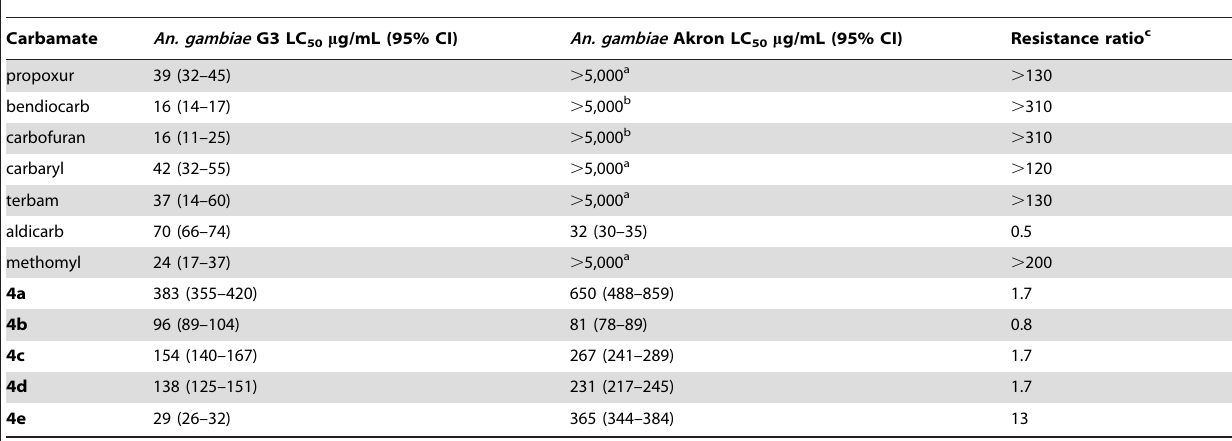
Table 4. Tarsal contact toxicity (24 h) to G3 and Akron strain An. gambiae , and toxicity resistance ratios. Carbamate